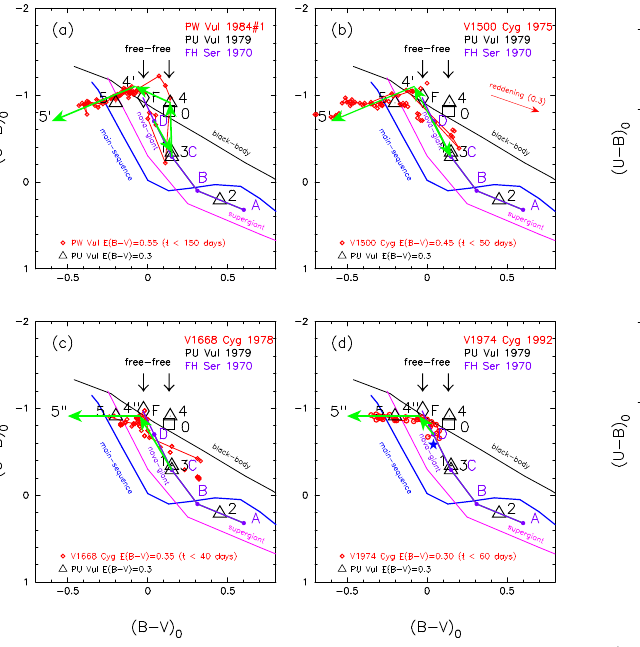
Figure 3: Several typical tracks of novae in the color- color diagram